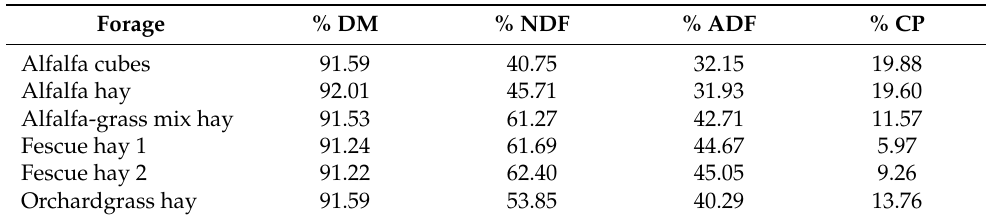
Table 2. Nutrient analysis of forages (% DM basis) with NDF and ADF determined by wet chemistry and CP determined by NIR